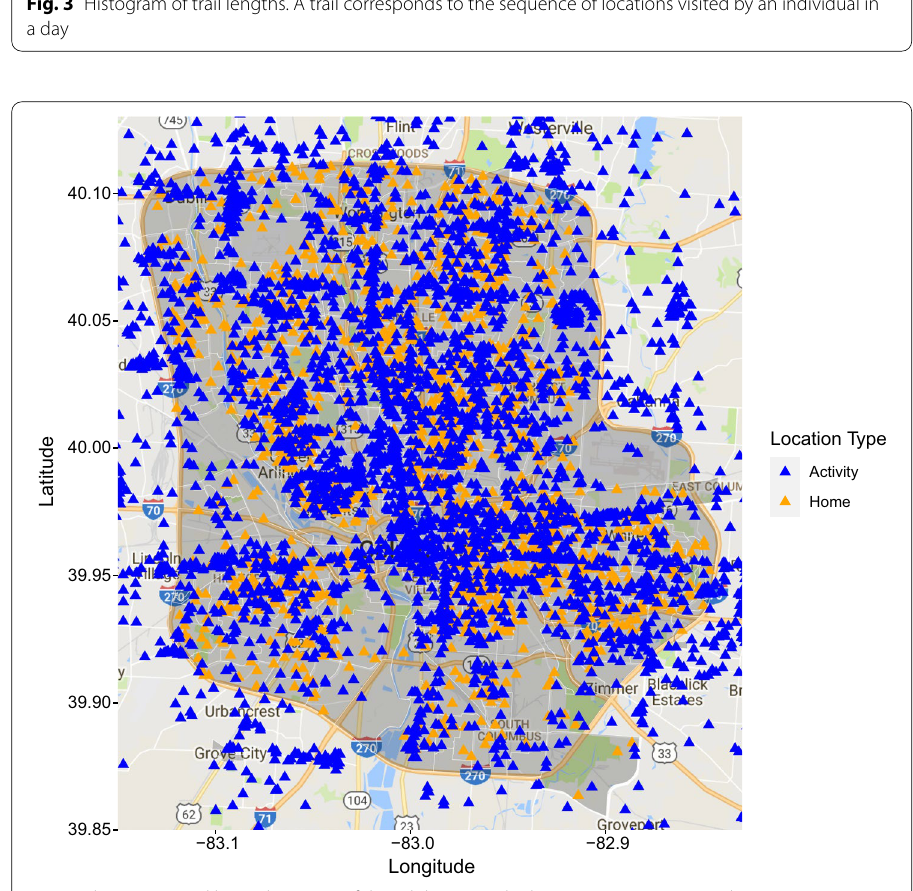
Fig. 4 The activity and home locations of the adolescents. The locations are anonymized (anonymization process is explained below (see figure reference in main